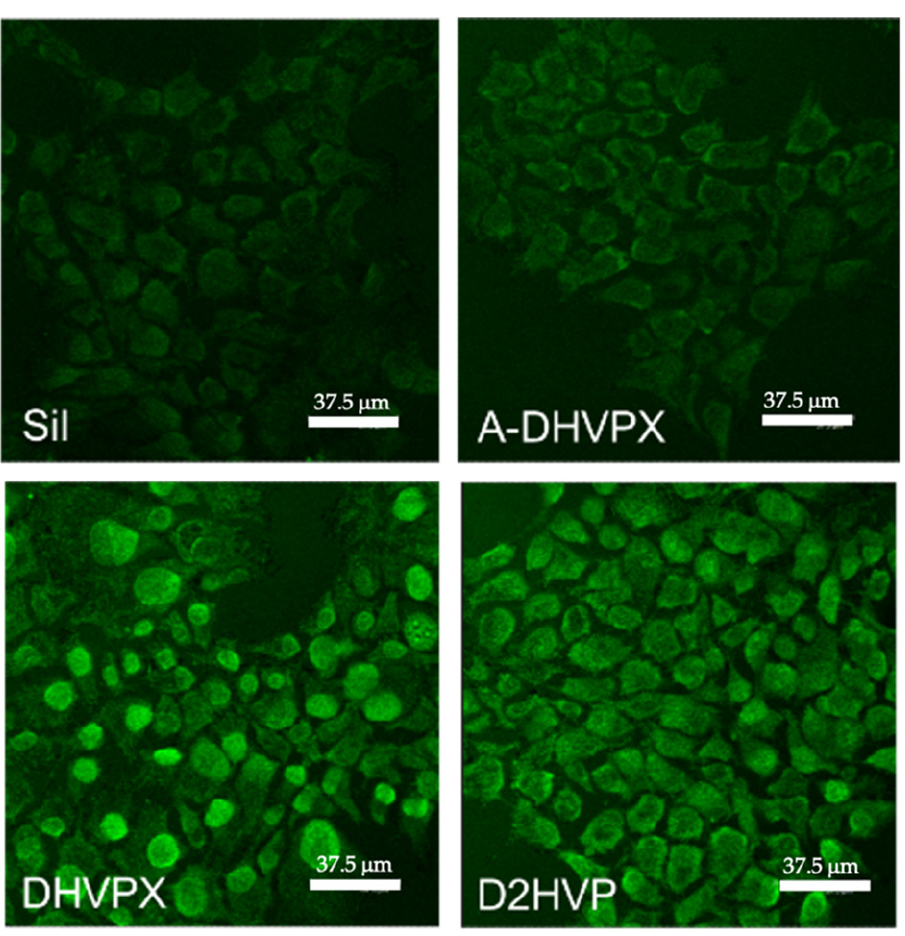
Figure 3. Phosphorylation of FAK. p-FAK detection was detected in h-osteoblast cells by Immuno- histochemistry. Cells were cultured on differently functionalized glass coverslips for 24 h. “Sil” represents the silanized glass coverslips. Images were evaluated by confocal microscopy. Scale bars are 37.5 μ m.